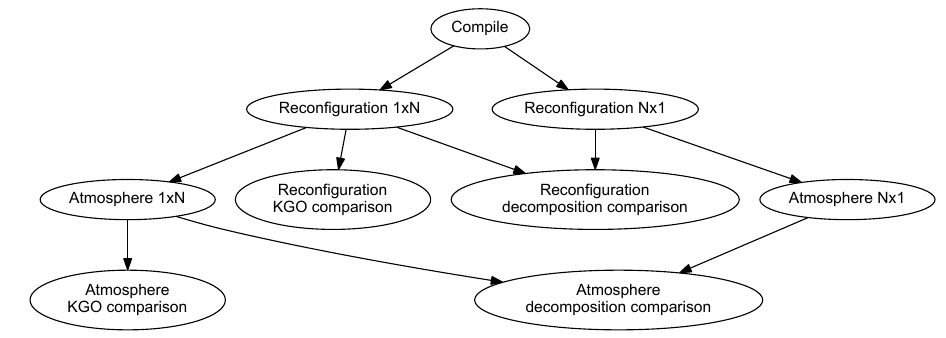
Figure 3. Simplified example rose-stem graph, showing the different tasks performed during a single